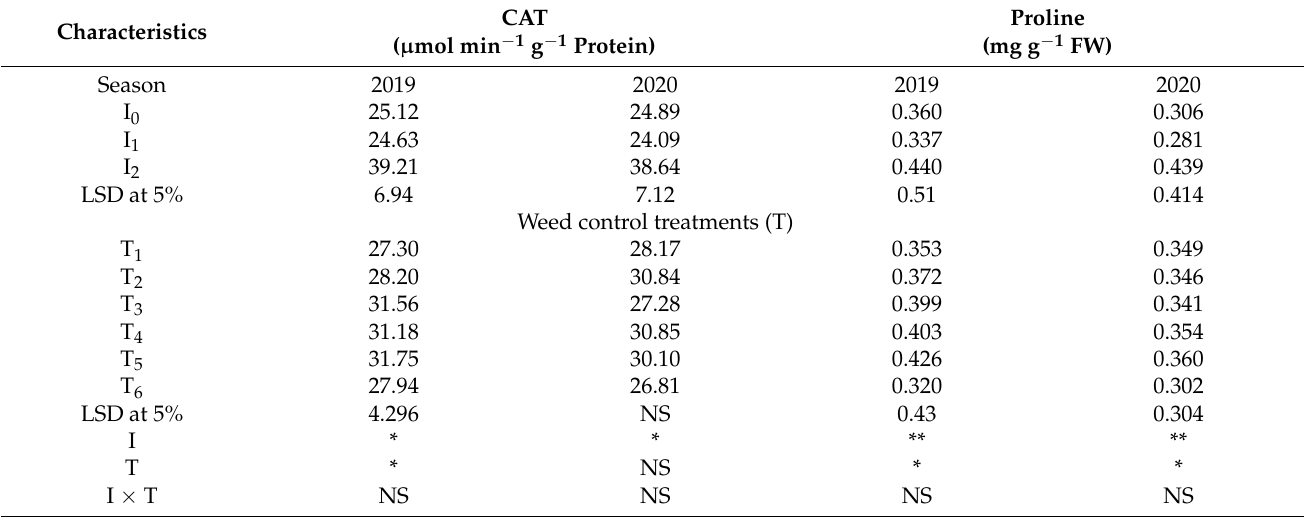
Table 10. Effect of irrigation levels and weed control treatments on CAT activity ( µ mol min − 1 g − 1 protein) and Proline content (mg g − 1 FW) of seed soybean in the 2019 and 2020